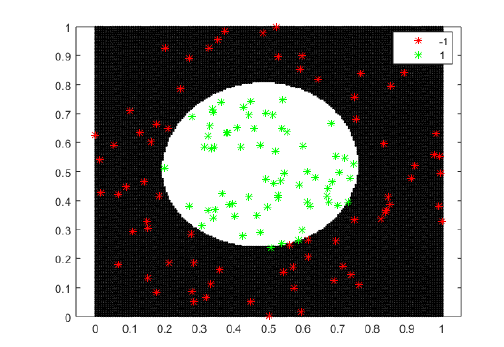
Fig. 5: Final Model.